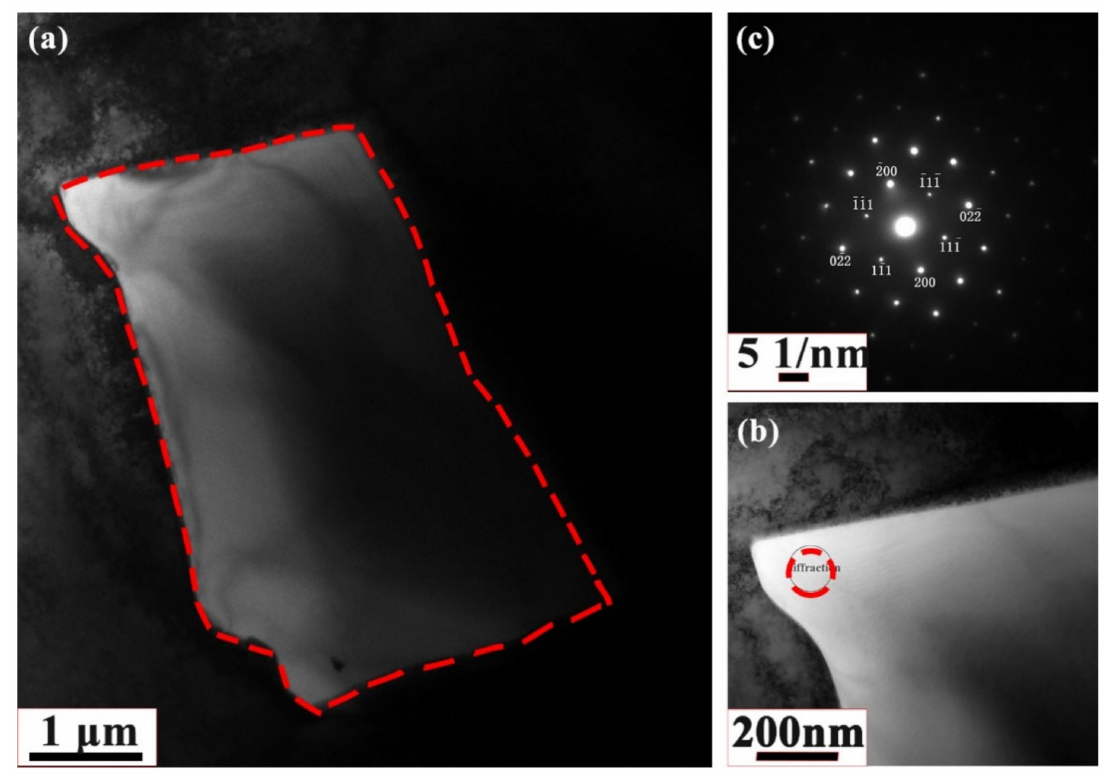
Figure 4. Representative TEM images of the medium entropy alloy CrCoNiAl 0.014 under one pass rolling: ( a ) Transmission electron microscopy (TEM), ( b ) Partial enlarged image, and ( c ) Electron diffraction pattern of the [011] crystal plane from the selected area highlighted by the dashed circle in ( b ).